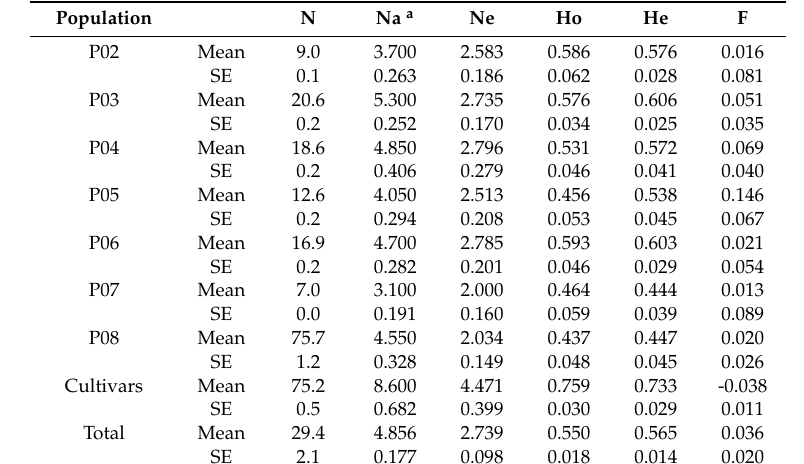
Table 2. Genetic diversity estimates for each analyzed population of wild and cultivated grapevines. Population P01 was excluded due to an insu ffi cient number of individuals (only two) for population genetic